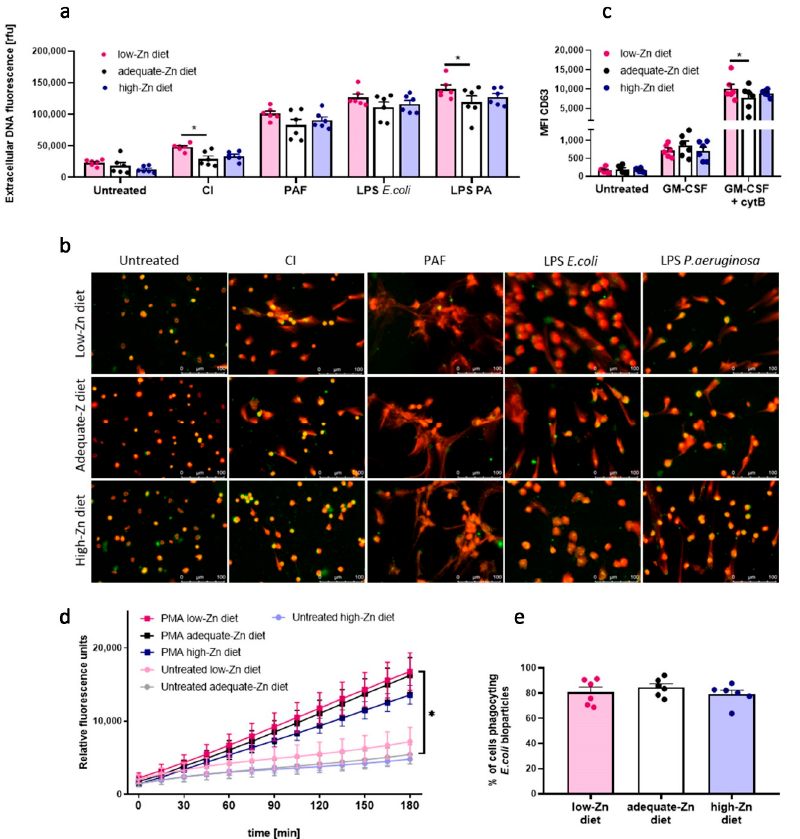
Figure 5. Neutrophils of mice fed low-zinc content diet present decreased NETs release. Mice fed with a low-zinc and high-zinc content diet were sacrificed, and bone marrow neutrophils were isolated. ( a , b ) NETs release was stimulated with 4 µ M CI, 10 µ M PAF, 20 µ g/mL LPS E. coli , 40 µ g/mL LPS P. aeruginosa . Next, NETs release was analyzed by ( a ) fluorometry and ( b ) fluorescent microscopy. ( c ) Degranulation of CD63 was analyzed by flow cytometry. ( d ) ROS production was analyzed by fluorometry. ( e ) Percentage of phagocyting cells was analyzed by flow cytometry. ( a , c , d ) Two-way ANOVA with post hoc Dunnett’s test. ( e ) One-way ANOVA with post hoc Dunnett’s test. The means ( a , c , e ) + SEM; ( d ) ± SEM; ( a , c , e ) with individual values are shown; n = 6; * ( p ≤ 0.05). NE: neutrophil